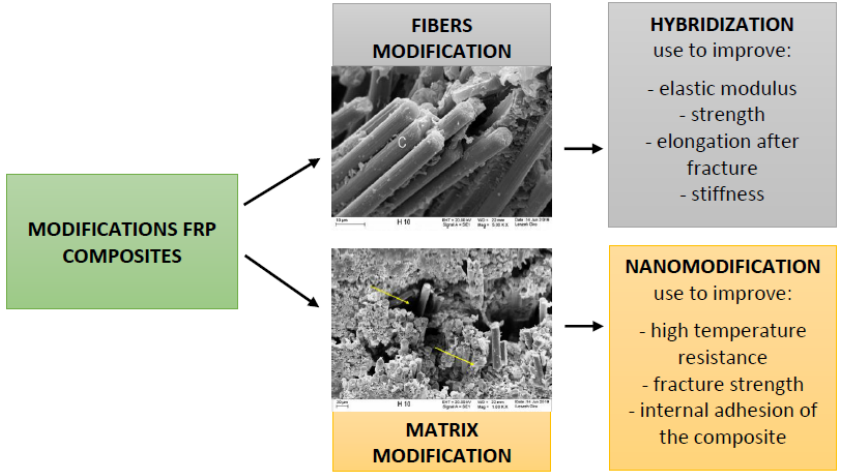
Figure 1. Modification scheme of individual components of the composite-fibers and matrix, and its potential impact on the main final properties of the resultant material.